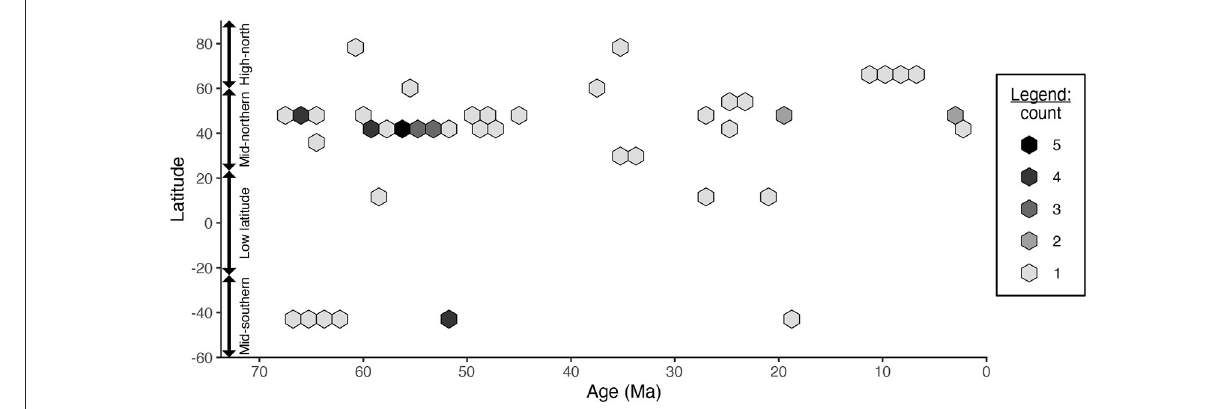
FIGURE2 The age and latitude of the fossil assemblages included in Currano et al. (2021)’s latitudinal